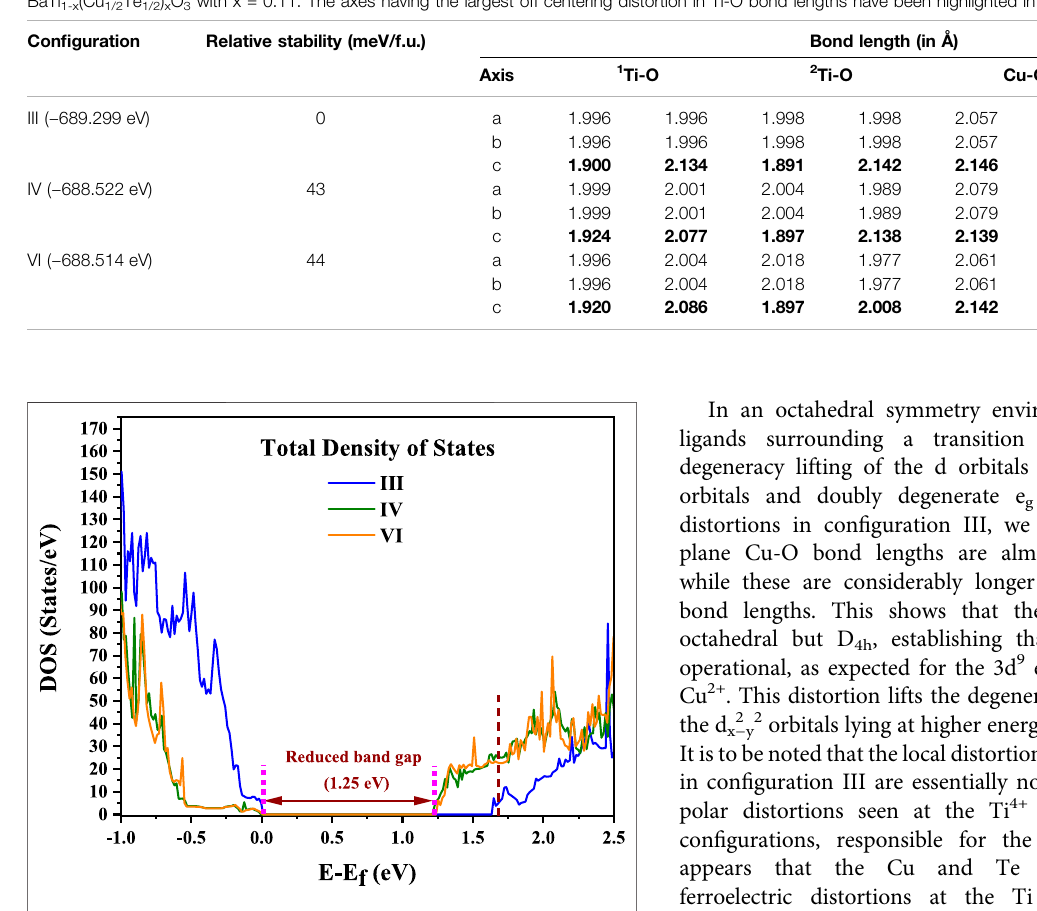
FIGURE 3 | Spin polarized total density of states (TDOS) calculated using DFT + U (U (cid:2) 6 on Cu) for the con fi gurations III, IV and VI for BaTi 1-x (Cu